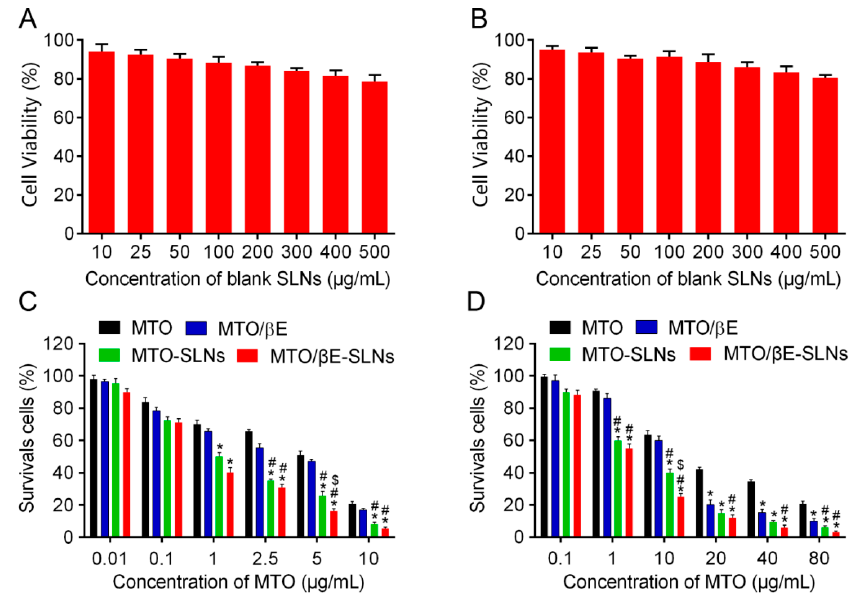
Figure 2. ( A ) In vitro cytotoxicities of blank SLNs in K562 cells after 48 h of incubation. ( B ) In vitro cytotoxicities of blank SLNs in K562 / DOX cells after 48 h of incubation. ( C ) In vitro cytotoxicities of MTO, MTO / β E, MTO-SLNs, and MTO / β E-SLNs in K562 cells after 48 h of incubation. ( D ) In vitro cytotoxicities of MTO, MTO / β E, MTO-SLNs, and MTO / β E-SLNs in K562 / DOX cells after 48 h of incubation. Data represent means ± SD ( n = 3). * p < 0.05 versus MTO; # p < 0.05 versus MTO/ β E; $